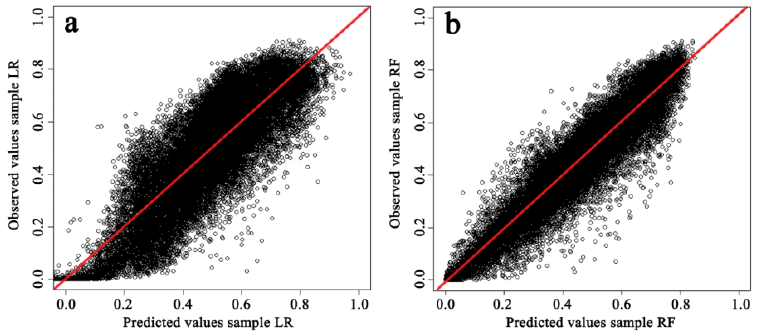
Figure 4. Plots of observed and predicted values calculated by Multiple Linear Regression ( a ) and Random Forest ( b ).